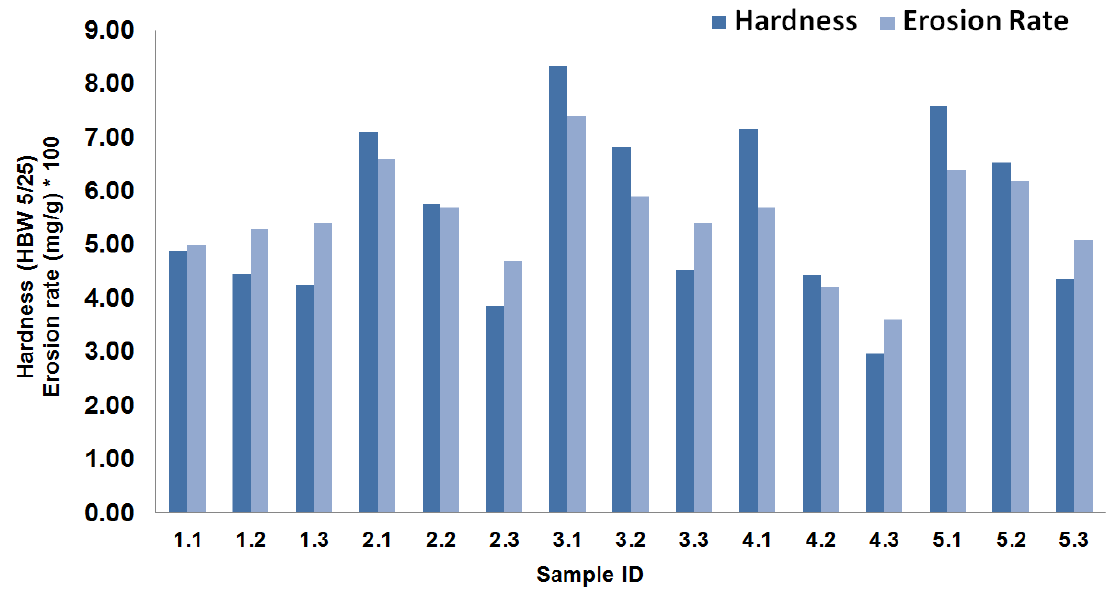
Figure 3. Hardness and erosion rate (multiplied by 100) for all coated